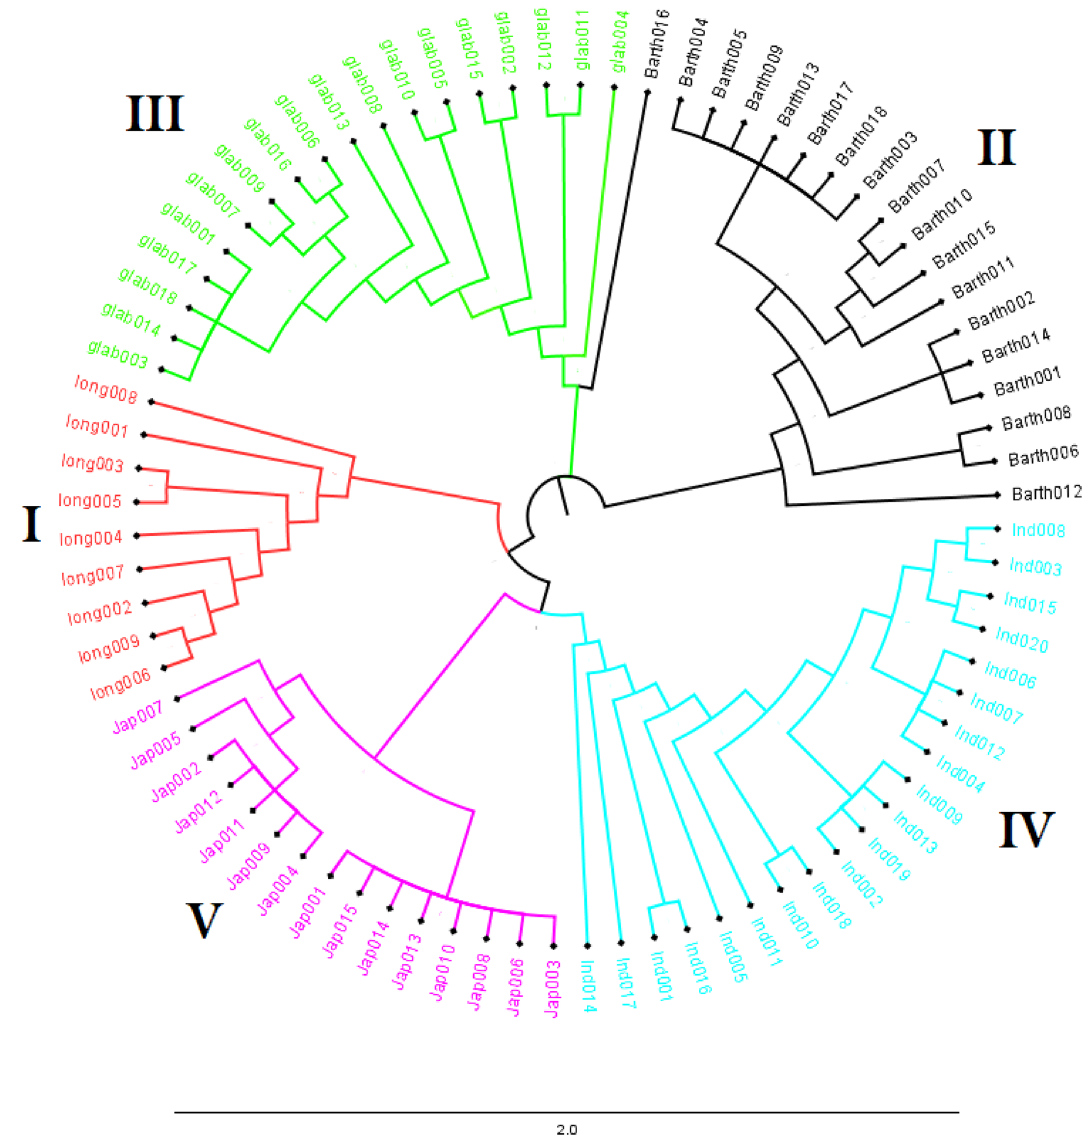
Figure 1. Phylogenetic tree constructed using the Neighbor-Joining method based on 80 rice accessions representing O. glaberrima (18), O. barthii (18), O. longistaminata (9), O. sativa spp. indica (20) and O. sativa spp. japonica (15) genotyped with 65 KASP SNPs diagnostic markers. Details about the 80 rice accessions are provided in the Supplementary Table S2. The colors in the tree correspond to subpopulations, as follows: Cluster I in red represents O. longistaminata accessions; Cluster II in black represents O. barthii accessions; Cluster III in green represents African rice O. glaberrima accessions; Cluster IV in blue represents Asian rice O. sativa spp. indica accessions; and Cluster V in pink represents Asian rice O. sativa spp.